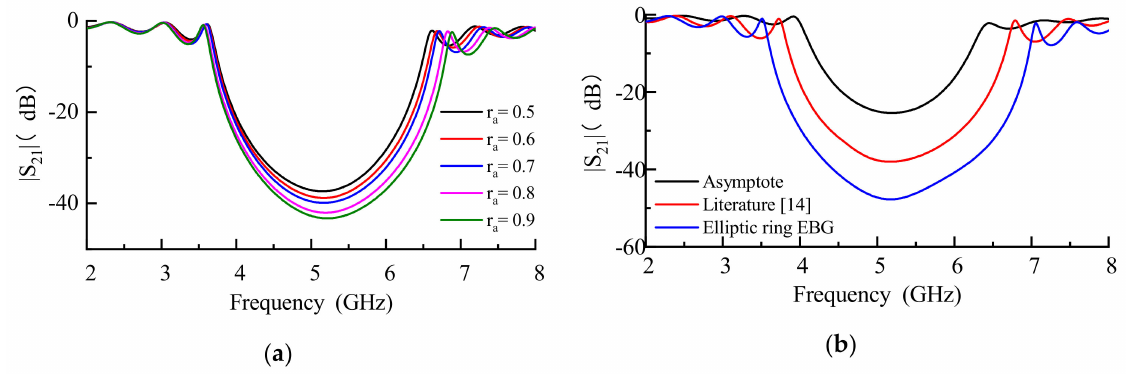
Figure 18. ( a ) Simulation results with di ff erent r a using HFSS; ( b ) comparison of the filter in Reference [14] with the filter etched with the elliptical ring.